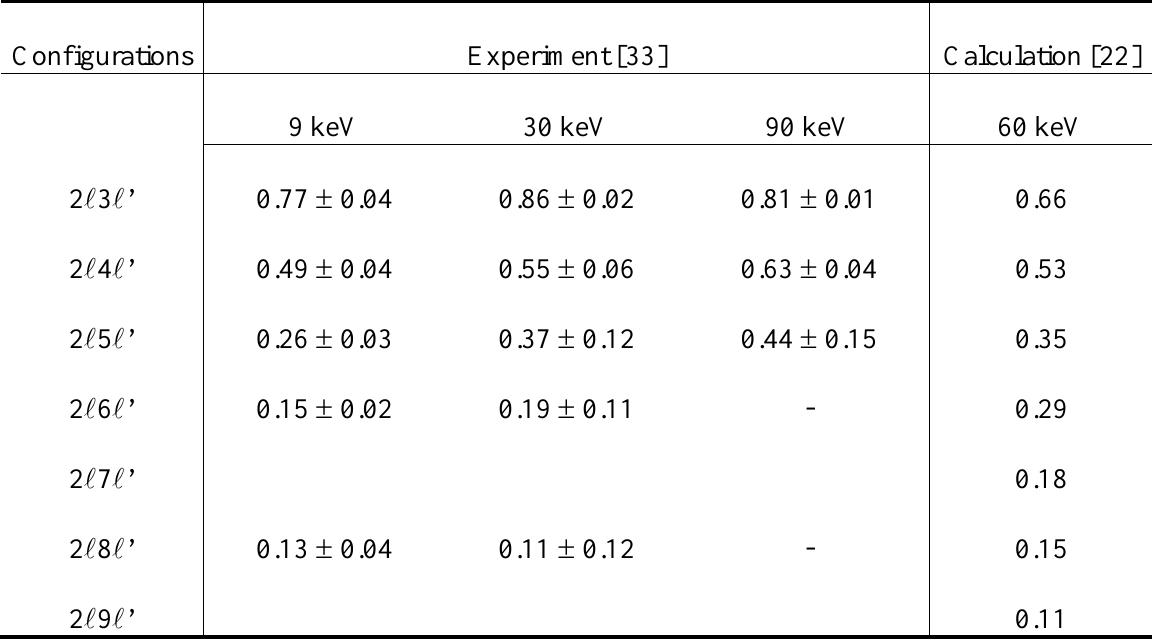
Table 1. Experimental and theoretical Auger yield a